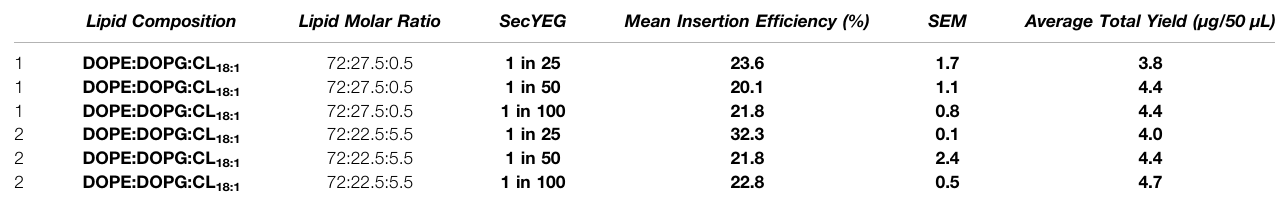
TABLE 4 | Investigations were conducted in lipid conditions comprising 72:27.5:0.5 and 72:22.5:5.5 mol ratios of DOPE:DOPG:CL 18:1 , with each protein: lipid ratio of SecYEG.Themeaninsertionef fi ciencies(%)arepresentedforeachlipidconditionwhereSecYEGispresentateachconcentration.ErrorspresentedareSEMcalculated from a minimum of 2 repeats. The total protein yields after puri fi cation are presented in Supplementary Table S4 . All experiments were conducted in Expressway ™ . Lipid Composition Lipid Molar Ratio